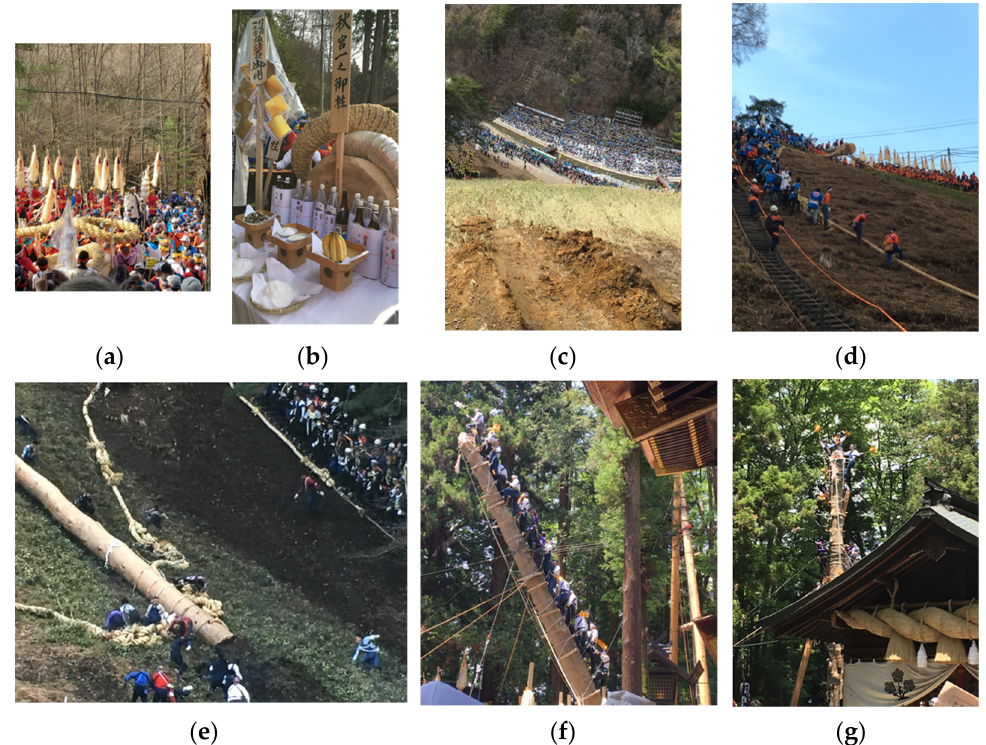
Figure 7. The Onbashira festival in 2016: ( a ) Tanakoba , the starting point of the festival of Yamadashi ; ( b ) Onbashira being purified before the beginning of the festival; ( c ) View from the top of Ki-otoshi Zaka with its 35 degrees slope. The soil on the ground was removed when Onbashiras were dropped; ( d ) Just before the drop of Onbashira on the slope; ( e ) Ki-otoshi is the highlight of Yamadashi (this picture is taken from the TV screen of LCV (LCV Corp. is a cable television station serving Suwa and Tatsuno areas in Nagano Prefecture), which broadcasts the scene of the festival in real time, as it is dangerous to take part in Ki-otoshi Zaka ); ( f ) The festival of Satobiki , where the Onbashira was brought to the precinct and gradually erected vertically; ( g ) The vertical standing Onbashira .